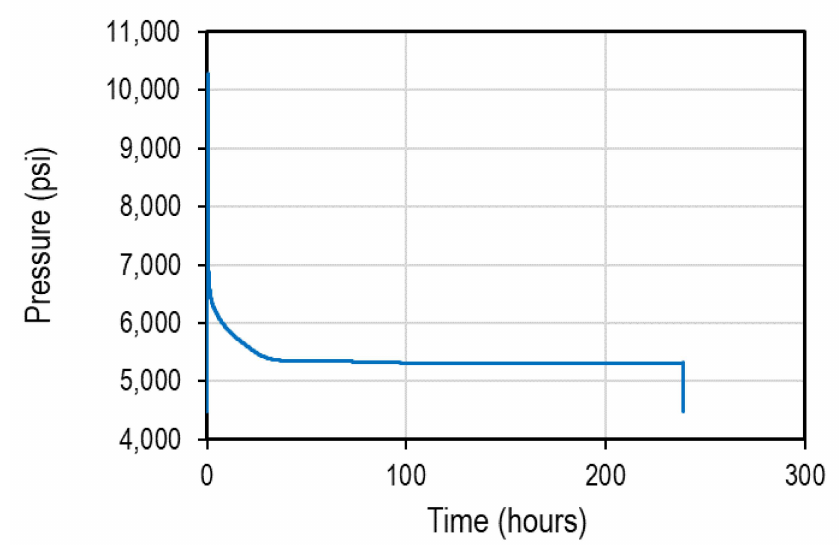
Figure 8. DFIT pressure changes during the 10 days for Well #1 (Woodford Formation).